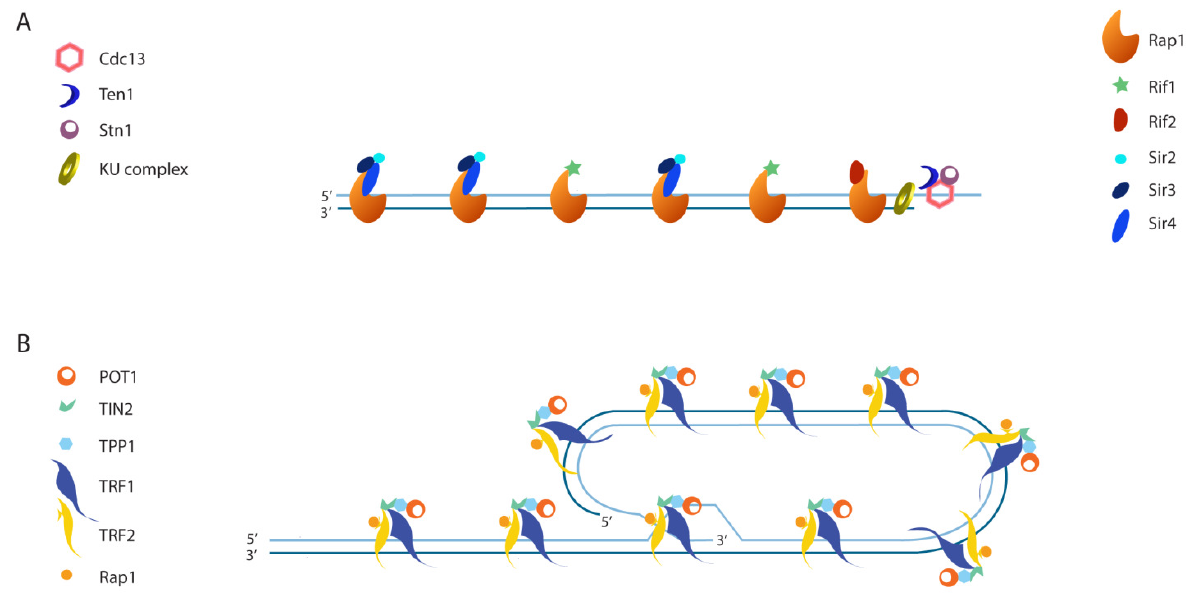
FIGURE 3: (A) Schematic of an S. cerevisiae telomere with associated proteins. (B) Schematic of shelterin-bound mammalian telomeres shown in a t-loop